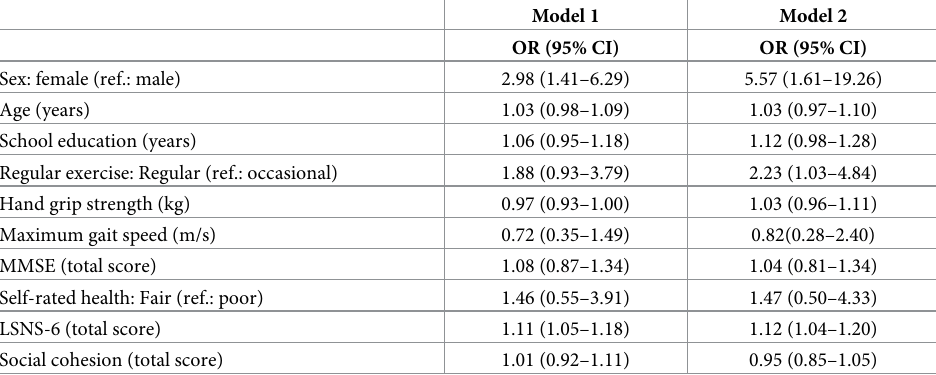
Table 3. Odds ratios (95% confidence intervals) for participation in sports groups at